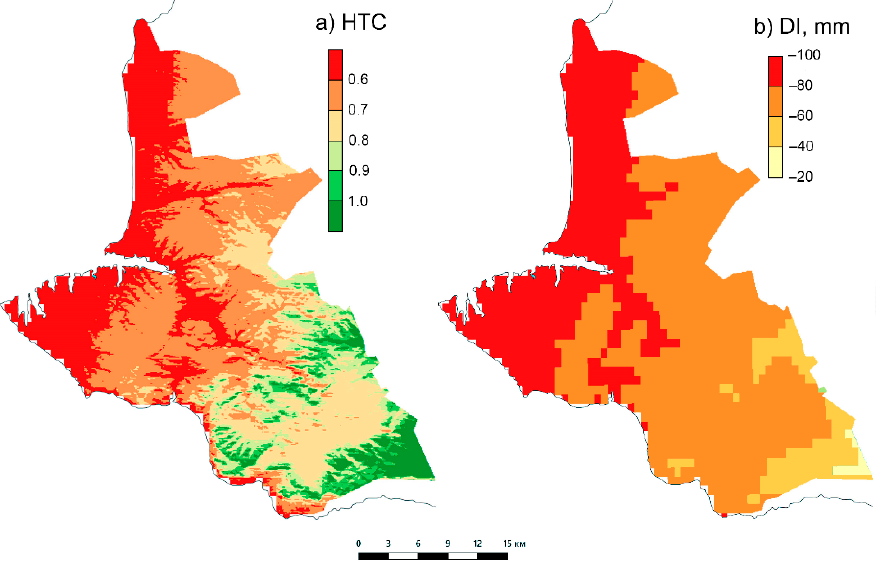
Figure 3. Spatial distribution of ( a ) HTC and ( b ) DI in the Sevastopol region between 1991 and 2020.